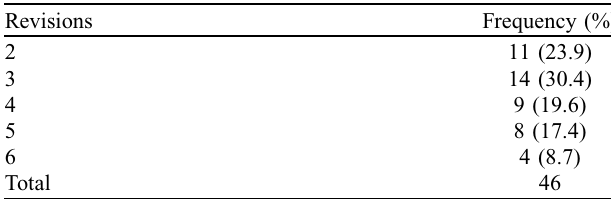
Table 1. Revisions prior to this treatment.